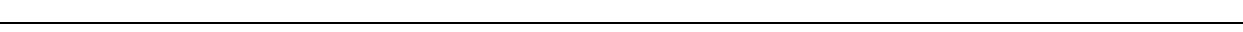
Fig. 2 EphB1 acts via ephrin-B1 to induce astrocytic STAT3 activation, and increases transcriptional activity. a Immuno fl uorescence showing nuclear localisation of pSTAT3 (nSTAT3) in ALDH1L1-positive astrocytes (ACs) untreated in Sato ’ s medium or stimulated with EphB1 or IL-6. b Graph shows the percentage of astrocytes displaying nSTAT3 ( n = 6 cultures from 6 mice; **** p ≤ 0.0001, F = 370). c WBs of ephrin-B1, total STAT3, pSTAT3 and β -actin, comparing protein levels following no treatment (Sato) and EphB1 or IL-6 treatments of non-transfected control astrocytes with ephrin-B1 siRNA silencing (see also Supplementary Fig. 9). d , e Graphs show relative band densities of ephrin-B1 ( d ) and pSTAT3 ( e ) to values of non-transfected control astrocytes in Sato ’ s medium. Data expressed as fold change after normalised to β -actin band density. N = 3 cultures from six mice; * p ≤ 0.05; ** p ≤